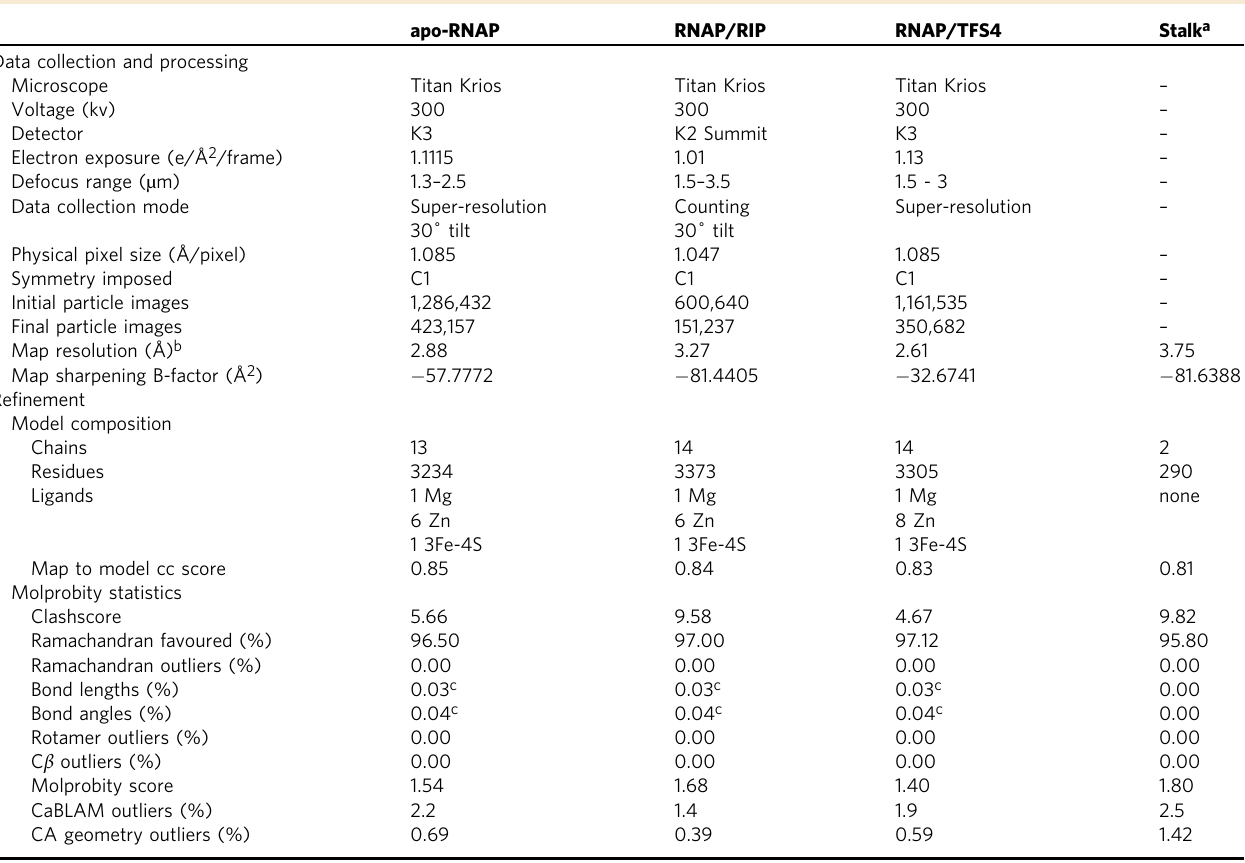
Table 1 Cryo-EM data collection and re fi nement